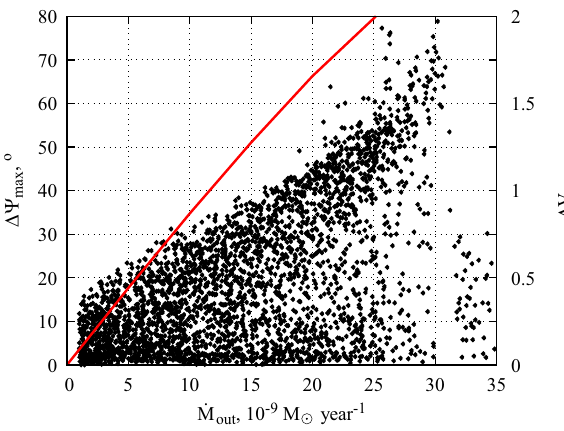
Figure 10: Dependence of the maximum change in the position angle on the mass out fl ow rate for the eclipse models from Figure 9 ( black dots ) . The red line shows the disk wind eclipse depth depending on the mass out fl ow rate.